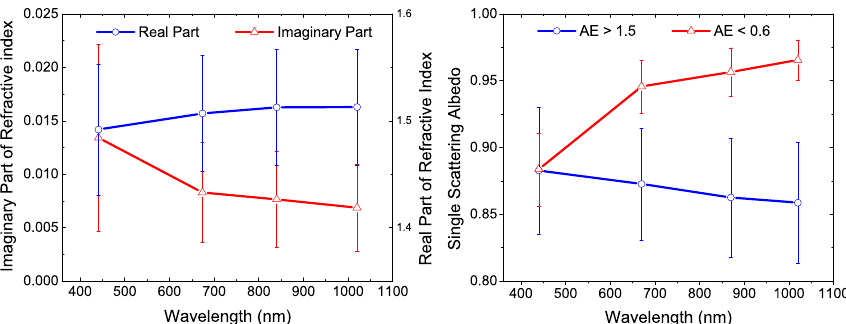
Fig. 4. Average aerosol refractive indices (left) and single-scattering albedo (right) obtained from sun–sky radiometer measurements from January 2010 to December 2010 in Beijing. The error bar shows the standard deviation, and AE on the right-hand panel denotes the Ångström exponent. AE < 0.6 denotes coarse-mode-dominated cases, while AE > 1.5 denotes fine-mode-dominated